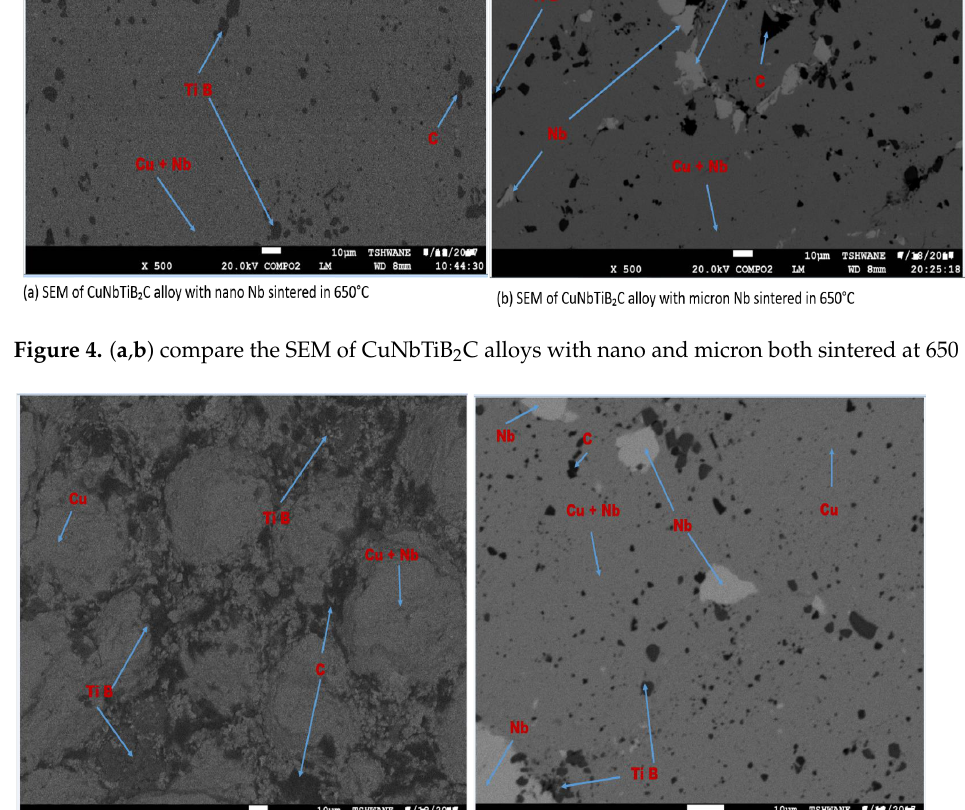
Figures 2 – 5 display the EDS analysis and SEM images of the sintered CuNbTiB 2 C multi-principal element alloys sintered at 650 °C and 700 °C. Figure 2a,b compare the EDS graphs of CuNbTiB 2 C alloys with nano-particles and micro-particles of Nb sintered at 650 °C, while Figure 3a,b compare the EDS graphs of CuNbTiB 2 C alloys with nano-particles and micro-particles of Nb sintered at 700 °C. Figure 4a,b compare the SEM of CuNbTiB 2 C alloys with nano and micro-particles of Nb sintered at 650 °C, while Figure 5a,b compare the SEM of CuNbTiB 2 C alloys with nano-particles and micro-particles of Nb sintered at 700 °C. At these sintered temperatures (650 °C and 700 °C), the resulting EDS graphs showed that the multi-principal element alloys still retained their purities after their ad- mixed powders were sintered. It was only in the alloy of CuNbTiB 2 C with nano-particles of Nb sintered at 700 °C that a trace of oxygen was found (Figure 3a). The presence of oxygen in the alloy (Figure 3a) indicated the presence of pores in the microstructure of that particular alloy (Figure 5a). However, the microstructures of other alloys showed no pores as no oxygen was found in their EDS graphs. The microstructure of the CuNbTiB 2 C alloy with nano-particles of Nb sintered at 700 °C (Figure 5a) shows the agglomeration of particles. This could be attributed to the nano-particles that were not evenly dispersed during the mixing of the powders, which might be the cause of the pores that evolved after sintering. In Figure 5a, the microstructure also shows a dendritic arrangement with the existence of graphite-rich and niobium-rich nano-segregations in the inter-dendritic areas. The microstructure of CuNbTiB 2 C with nano-particles of Nb sintered at 650 °C is seen to be more homogenous and denser as compared to others. The whitish pigments found in each of the microstructures are the concentrations of niobium (Nb) particles, while the black pigments are mostly the presence of titanium di-boride (TiB 2 ) particles and graphite (C) particles and the brownish pigments of copper (Cu) could not have re- flected but their particles were evenly dispersed in the microstructures of the alloys. The